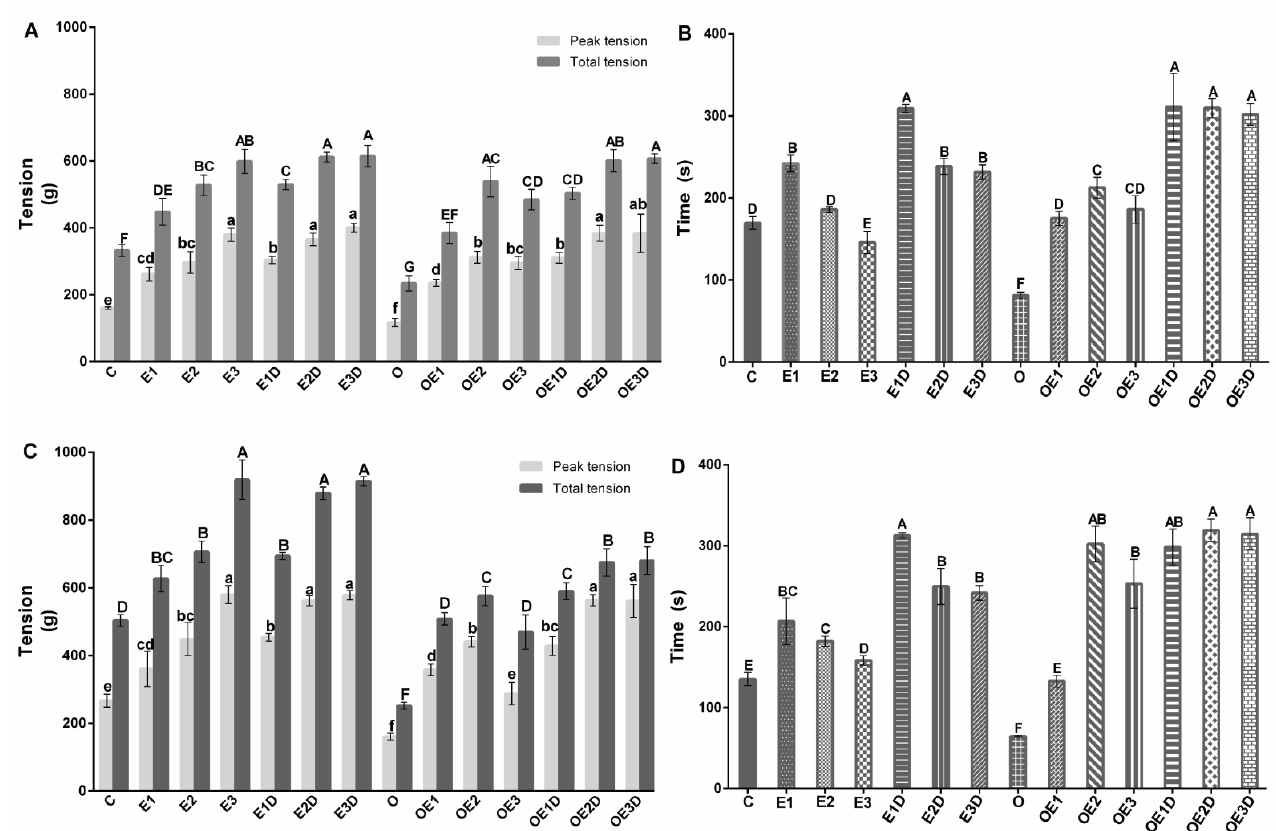
Figure 1. Effect of different intensities of exercise and diazoxide on muscle contraction and resistance to fatigue. ( A ) Maximum tension and total tension of the soleus muscle, ( B ) Endurance time to fatigue of the soleus muscle, ( C ) Maximum and total tension of the EDL muscle, ( D ) Endurance time to fatigue of the EDL muscle. C: control; D: diazoxide; E1: low-intensity exercise; E2: moderate- intensity exercise; E3: high-intensity exercise; E1D: low-intensity diazoxide exercise; E2D: exercise with moderate intensity diazoxide; E3D: exercise with high-intensity diazoxide; O: obese; OD: obese diazoxide; OE1: low-intensity exercise for obese; OE2: obese athlete of moderate-intensity; OE3: obesity due to high-intensity exercise; OE1D: low-intensity exercise diazoxide in obese; OE2D: moderate-intensity exercise for obese; OE3D: high-intensity diazoxide exercise for obese. Data are represented as mean ± standard error. Different letters indicate statistically significant differences between groups ( p < 0.05) 1-way ANOVA, Tukey’s posthoc test, n =